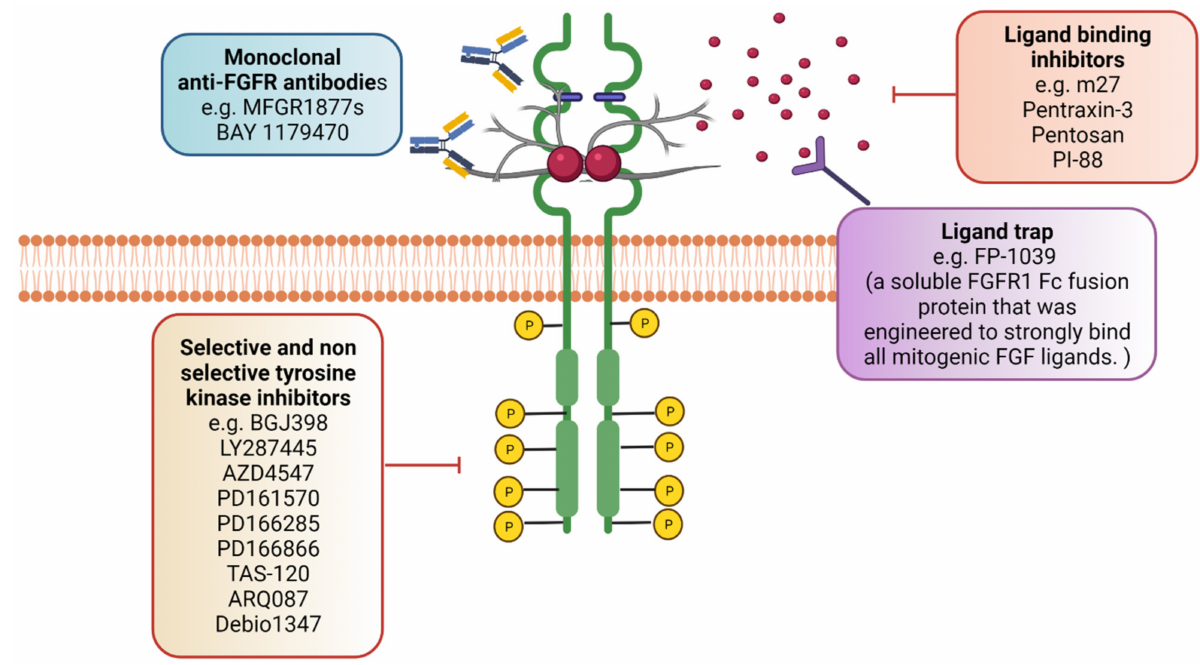
Figure 5. Targeting the FGFR axis. Aberrant FGFR signalling can contribute to cancer progression and therefore targeting FP-1039. can also block the FGF–FGFR interaction and therefore prohibit FGFR activation. In addition, ligand binding inhibitors that act as antagonists (e.g., PI-88 and sm27) can prevent FGFR activation. Monoclonal antibodies targeting specific FGFR isoforms (e.g., MFGR1877s by Genentech) can also have anti-tumour activity. Created with BioRender.com (accessed on 12 November